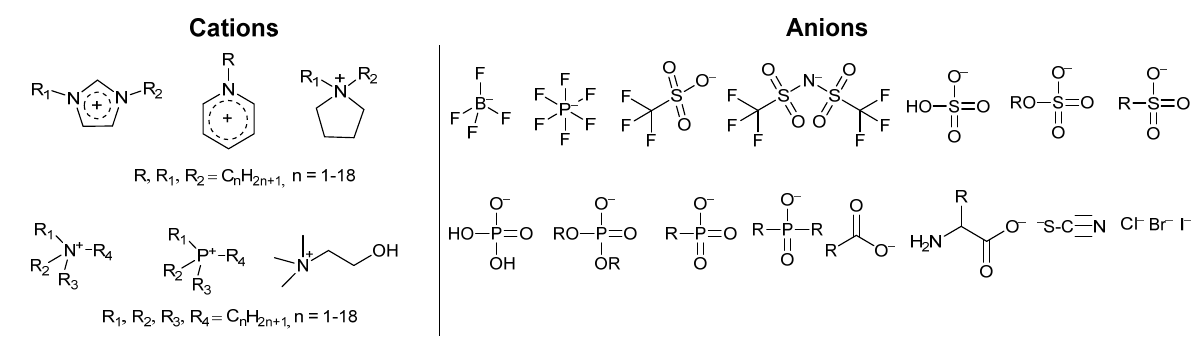
Figure 1. Common ionic liquids (cations and anions) used in biocatalysis applications.